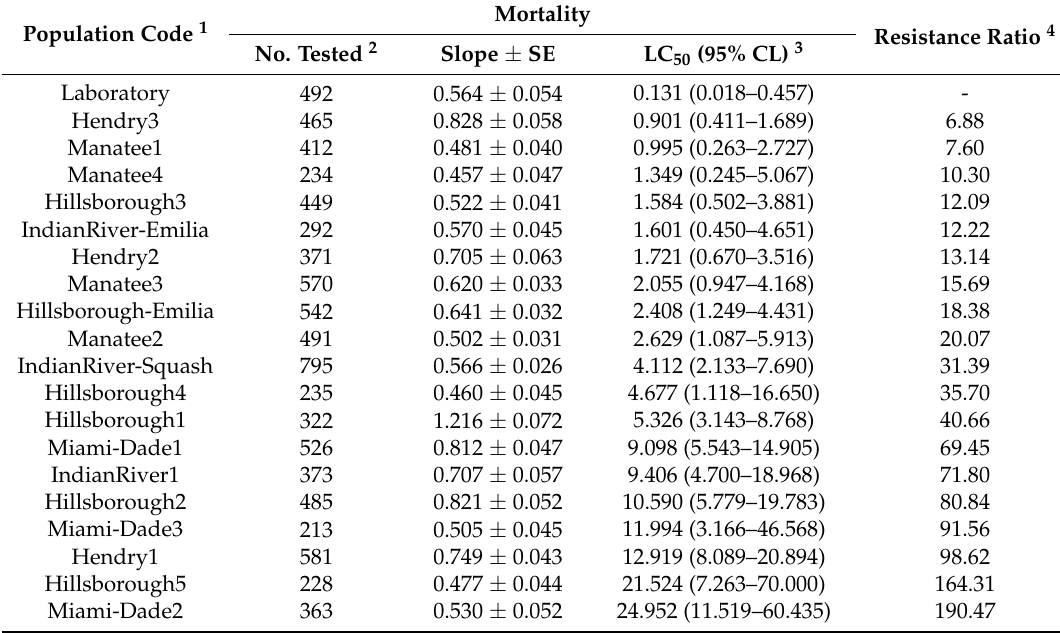
Table 1. Dose response to imidacloprid and resistance ratios of Bemisia tabaci adults, reared from Florida field-collected populations, as measured by mortality (LC 50 ) with a cut cotton leaf and petiole systemic uptake bioassay in the laboratory.